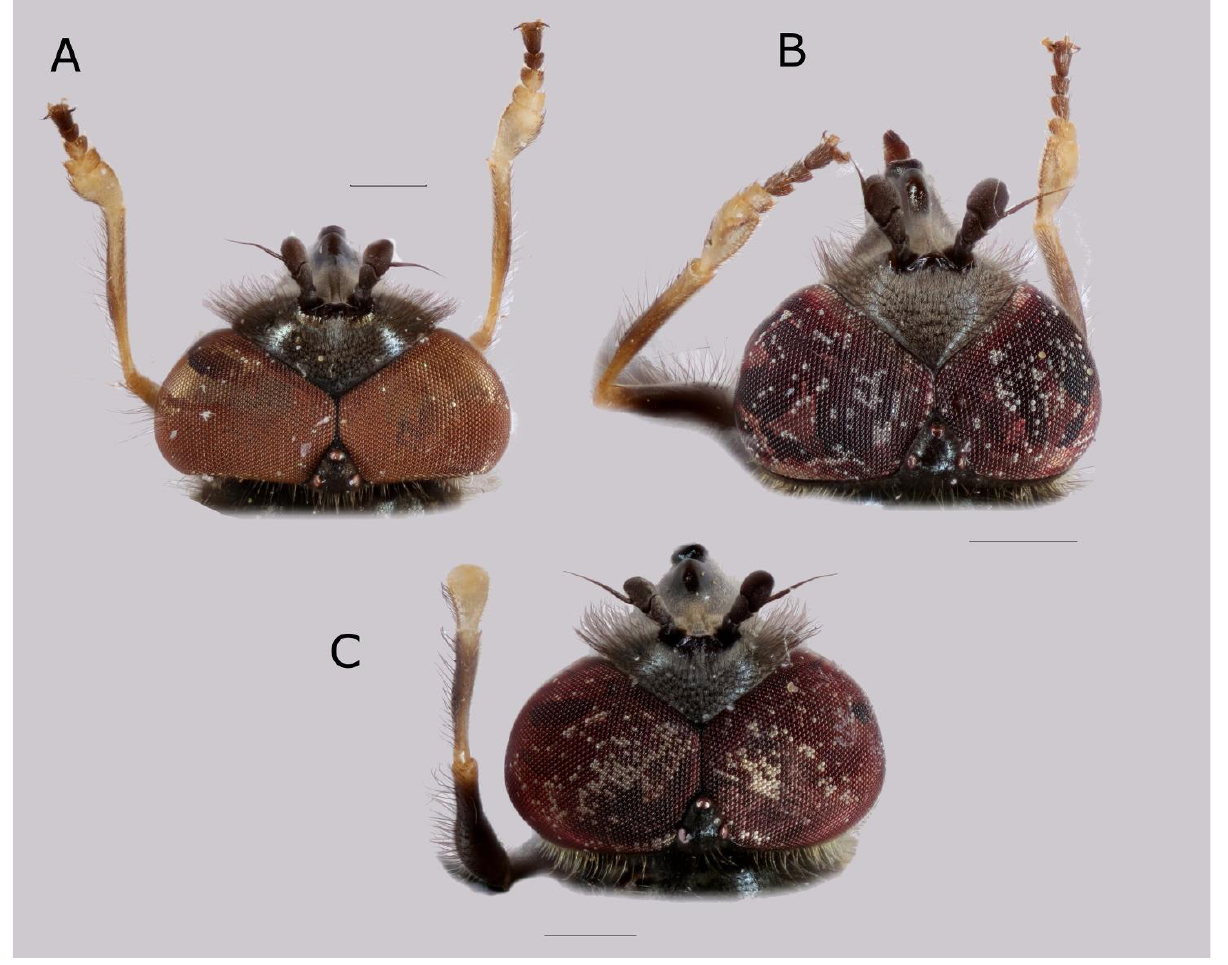
Figure 7. Adult male, head and prolegs, dorsal view: (A) Platycheirus groenlandicus , Ammarnäs, Sweden; (B) Platycheirus subordinatus , Seitajaure, Sweden; (C) Platycheirus torei , Seitajaure, Sweden. Scale bars 0.5